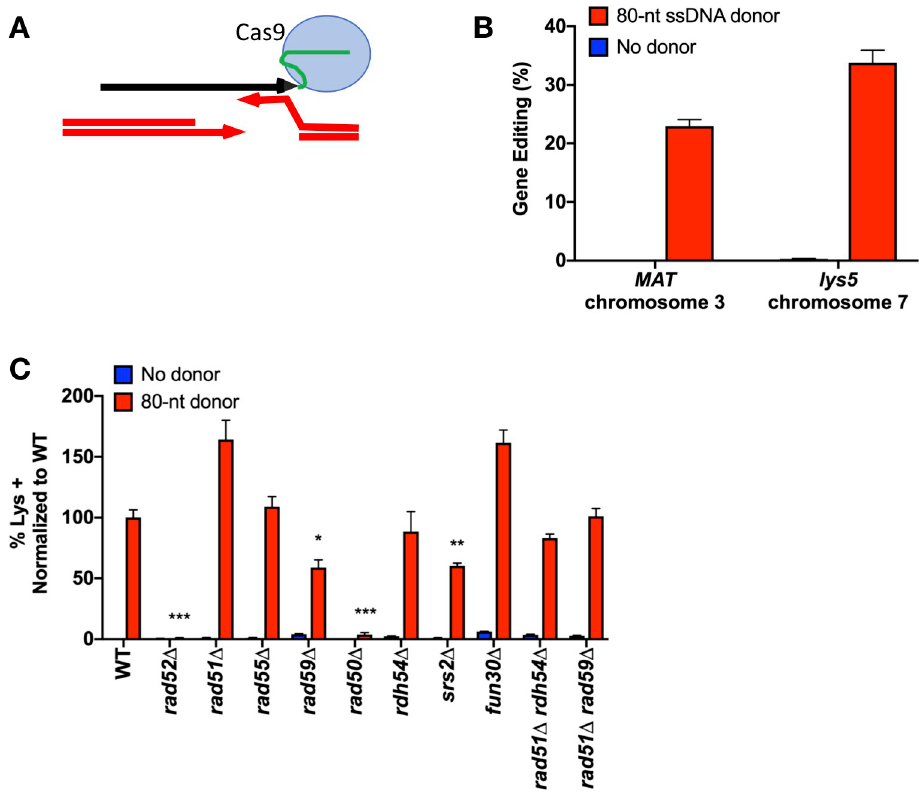
Fig 5. SSTR initiated by retron-Cas9 utilizes a Rad51-indepndent repair pathway. A) The retron system utilizes a modified Cas9 gRNA that tethers the ssDNA donor template to the RNA scaffolding of the Cas9 protein. Successful SSTR at the MAT locus results in the insertion of an Xho I restriction site, as in Fig 1. SSTR at the lys5 locus repairs a 5-bp insertion in the lys5 locus, resulting in Lys + recombinants. B) Efficiency of the Retron-Cas9 system at two chromosomal locations. Cells were plated onto URA - plates with dextrose (non-induction) and URA - with galactose (induction) media. At MAT , the percent gene editing was determined by PCR and Xho I digest of induction survivors as described in Methods. At lys5 , the percentage of gene editing was determined by replica plating URA-Gal survivors onto Lys - media. The resulting plate count over plate counts of URA - non-induction media results in % gene editing. C) Effect of recombination mutants on retron-Cas9 SSTR gene editing. After induction of the retron system on galactose-containing media, survivors were replica plates to Lys - media. The frequency of Lys + colonies was calculated as a percentage of total cells plated and normalized to wild type. Significance was determined using two-tailed t-tests compared to WT, using the two-stage Benjamini, Krieger, and Yekutieli false discovery rate approach [89], � p � 0.01, �� p � 0.001, ��� p � 0.0001. Error bars refer to the standard error of the mean. n = 3. r ad59 Δ compared to rad59 Δ rad51 Δ p =